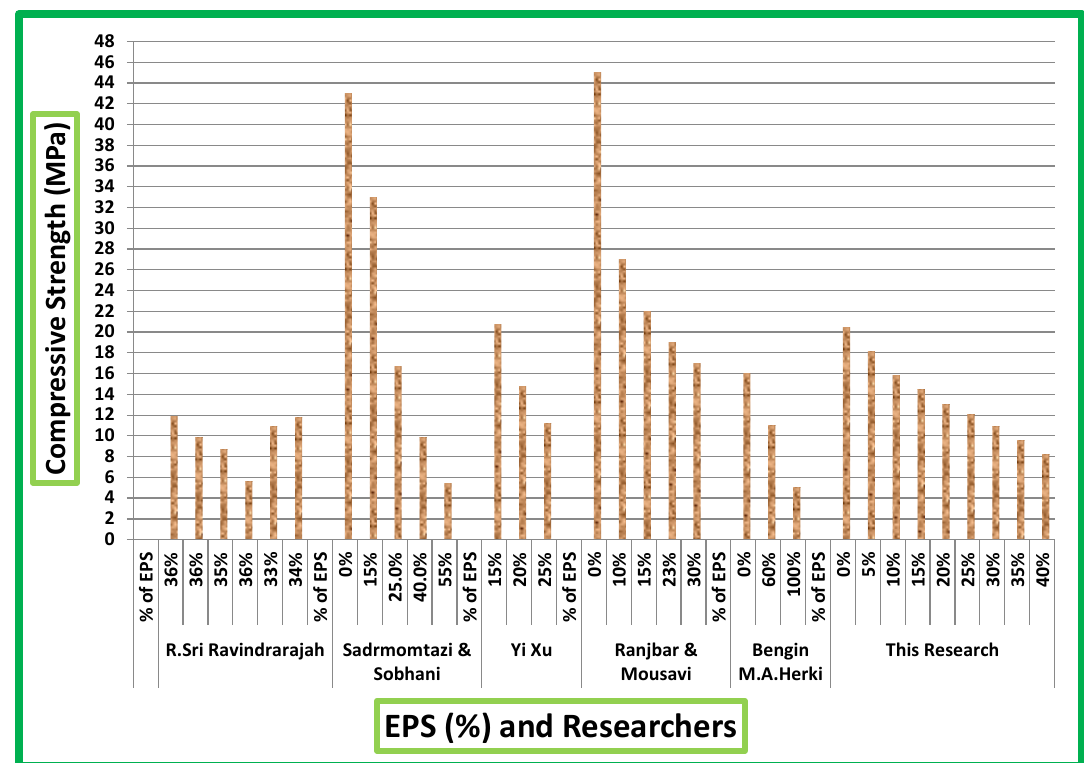
Figure 15. Comparative analysis of the compressive strength of this study with Ravindrarajah, R. Sri and A. J. Tuck [59], Sadrmomtazi, A., et al. [60], Xu, Yi, et al. [6], Ranjbar, M.M., and Mousavi, S.Y. [61] and Herki, B. [2].